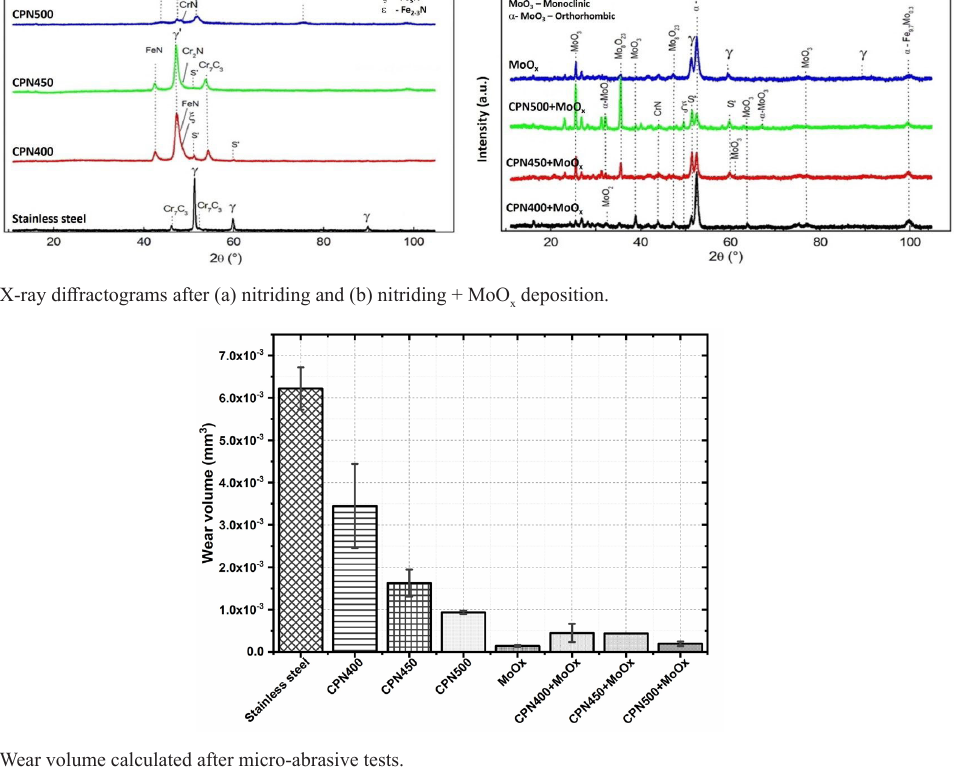
Figure 5. Wear volume calculated after micro-abrasive tests.